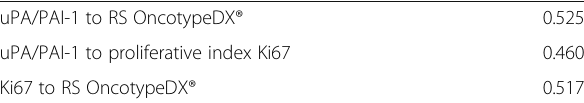
Table 3 Positive correlations between different variables (Spearman correlation)